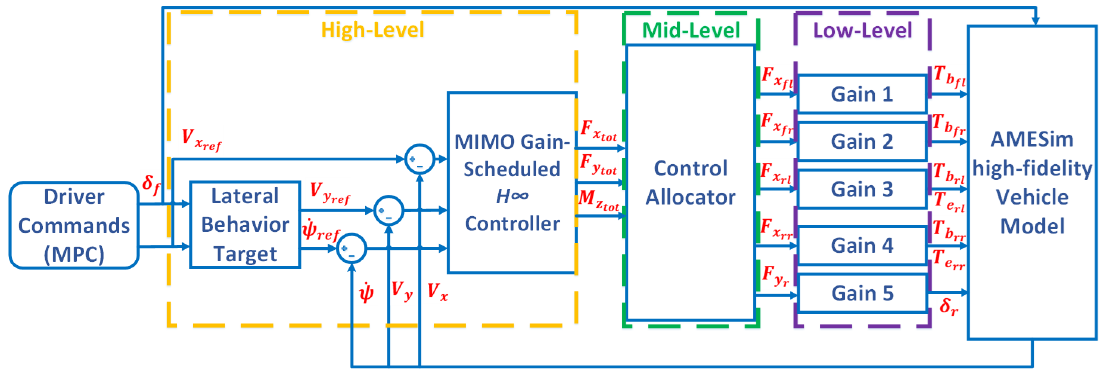
Figure 12. Vehicle motion multi-layered control